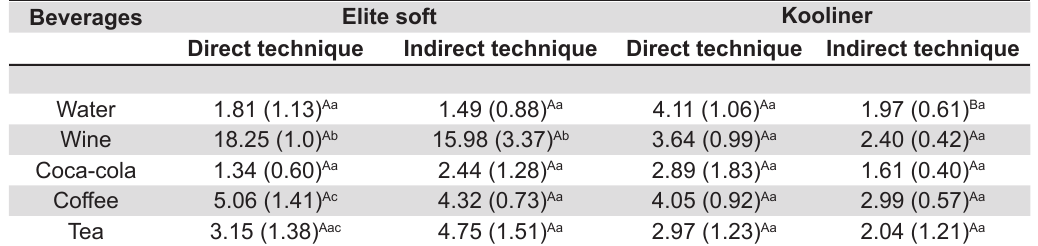
Table 4- Comparison of color change means (standard deviation) of the materials on interaction of techniques and